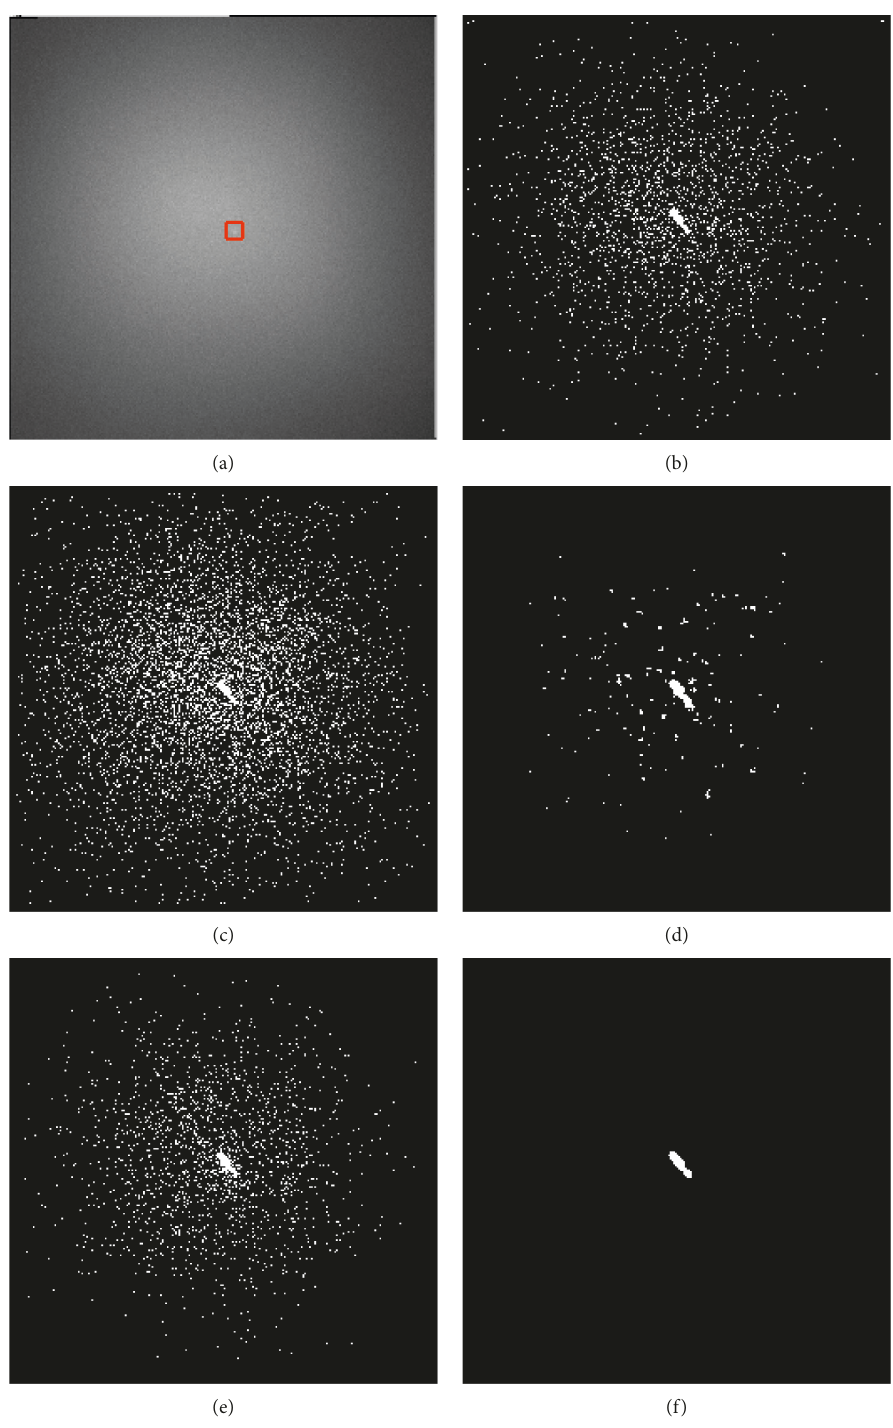
Figure 8: Detection results of different algorithms in scene